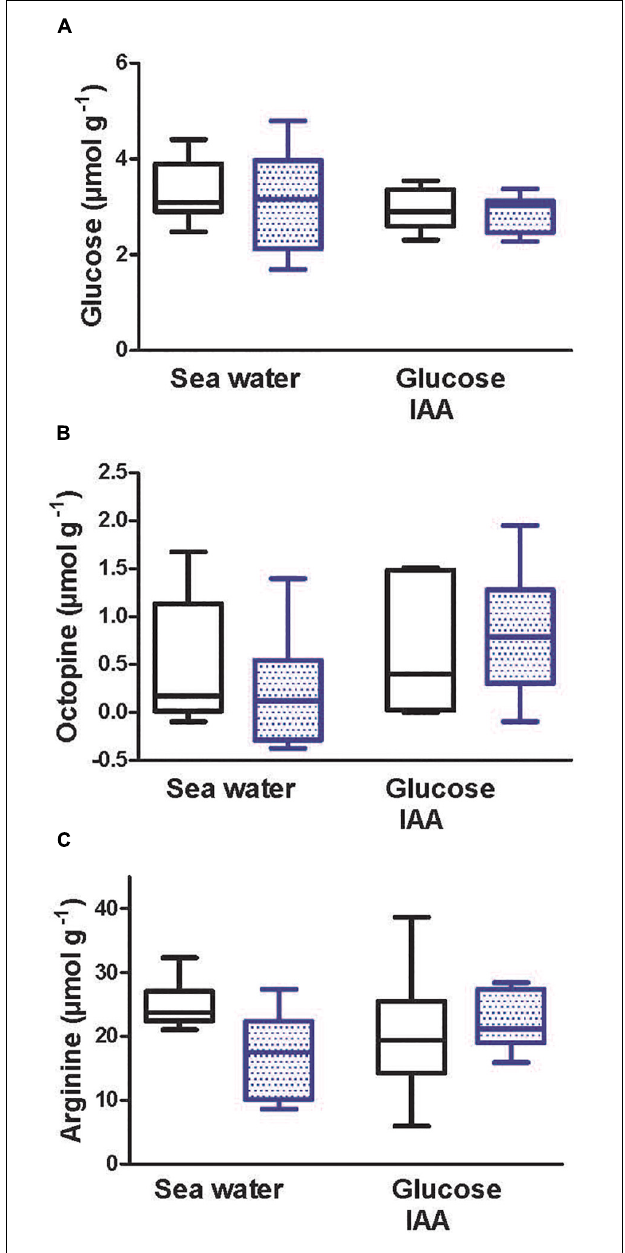
FIGURE 5 | Glucose (A) , octopine (B) , and arginine (C) levels in mantle muscle sheets immediately following intense contractility. One of two paired mantle sheets from cuttlefish ( Sepia officinalis ) was stimulated to contract for 30 s at 3 Hz simulating jetting behavior and thereafter analyzed. Open bars represent unstimulated preparations; stippled bars indicate preparations that were stimulated. Text below x -axis shows additions to media. For IAA additions, preparations were incubated for 10 min prior to stimulation. N = 6 under all conditions. Box and whisker plots show the range and median